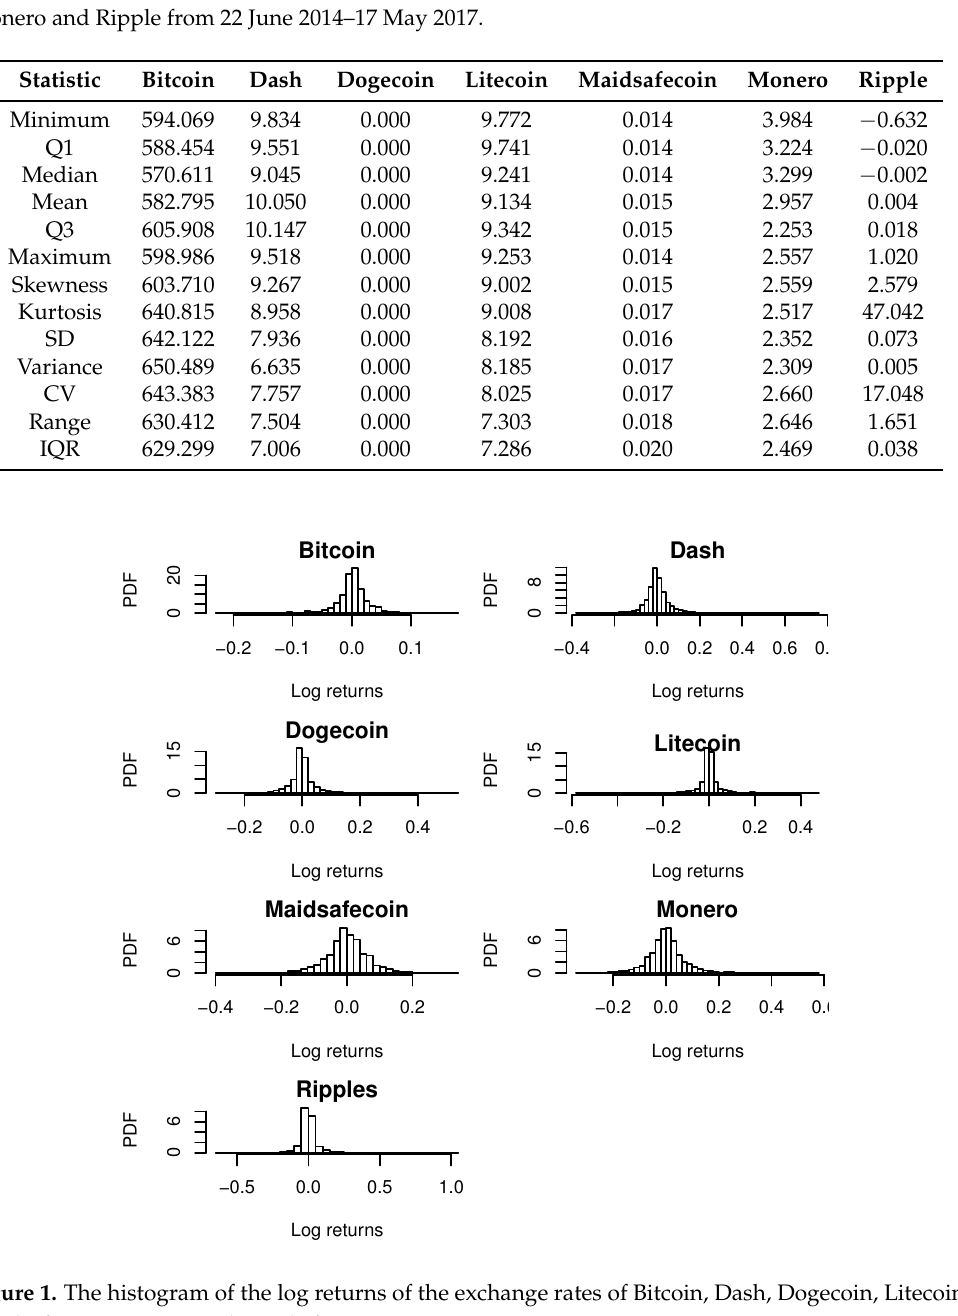
Table 1. Summary statistics of the exchange rates of Bitcoin, Dash, Dogecoin, Litecoin, Maidsafecoin,